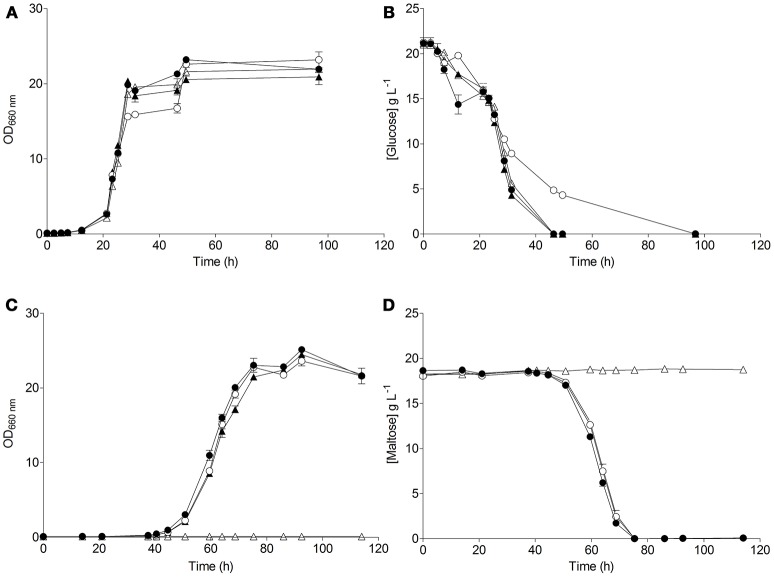
Characterization of the S. eubayanus strains () CBS 12357T, () IMK816 (SemalT1Δ), () IMK817 (SemalT2Δ SemalT4Δ), and () IMK818 (SemalT3Δ) during growth on glucose and maltose as sole carbon source. S. eubayanus strains were grown on SMG or SMM at 20°C. Growth on glucose (A) and on maltose (C) was monitored based on optical density measurement at 660 nm (OD660nm). Concentrations of glucose (B) and maltose (D) in culture supernatants were measured by HPLC. Data are presented as average and standard deviation of three biological replicates.